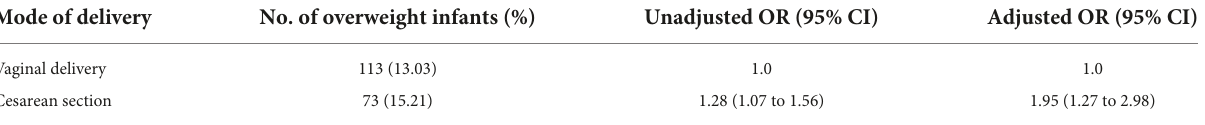
TABLE 2 Logistic regression associated of delivery mode with infant